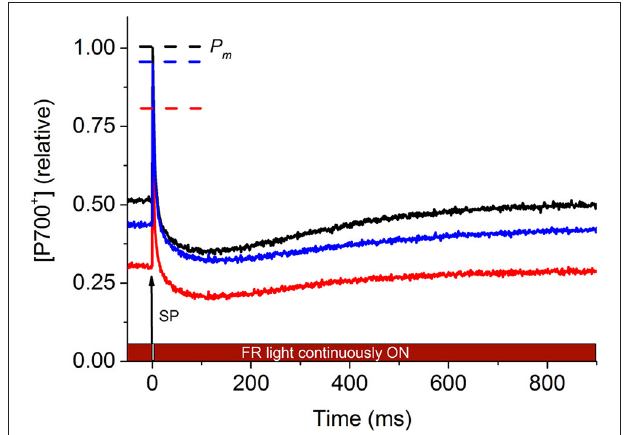
FIGURE 1 | Representative P700 + kinetics signals of P. decussata estimated based on the absorbance changes at 820 nm (in reflectance mode). Measurements were done at 25 ◦ C (control, black line), at 33 ◦ C (heat, red line), and 25 ◦ C after the heat treatment (recovery, blue line). P700 + signal intensity is shown in relative units as [P700 + ] (relative). The initial 50 ms of the signal represents the steady state P700 level in the presence of weak far-red light. At time point t = 0 ms, a saturating pulse (SP) was applied to fully oxidize P700 (thus all P700 reaction centers are in the form of P700 + , denoted as P m , representing the highest absorbance at 820 nm, dashed line with the respective colors of the different treatments). Electrons from PSII reduce P700 + , causing a decline in 820 nm absorbance to a level below the initial (first 50 ms) P700 redox level (because the reducing electron flow originating presumably from PSII exceeds the rate of forward electron flow out of PSI). As the weak FR light is continuously on (as indicated over the X axis), P700 gets reoxidized, causing the 820 nm signal to return to the steady-state level within ∼ 900 ms. For detailed description of P700 kinetics measurements, refer to Materials and methods. For heat-induced changes in P700 kinetics signal, refer to main